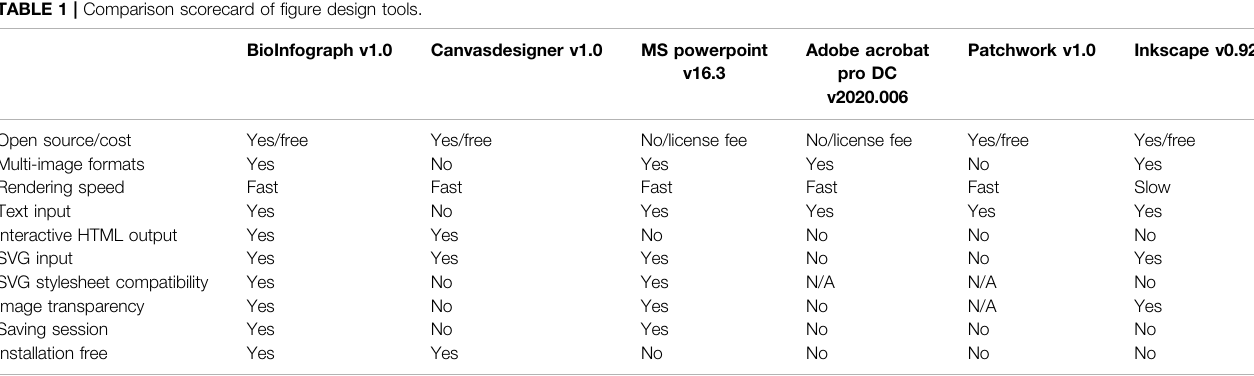
TABLE 1 | Comparison scorecard of fi gure design